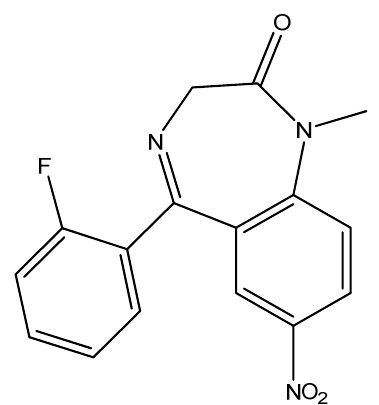
Figure 1. Chemical structure of